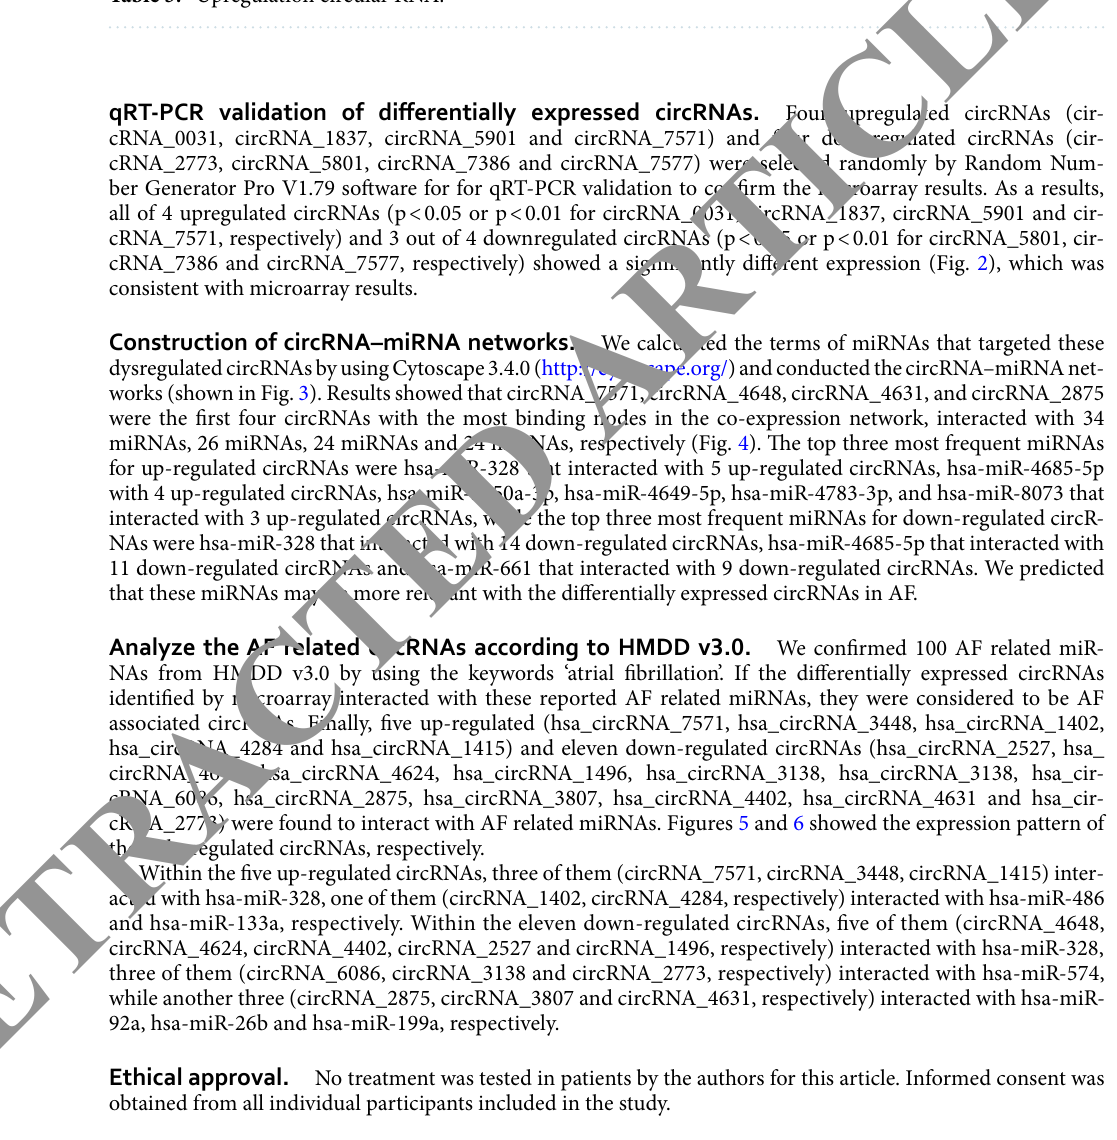
Table 3. Upregulation circular